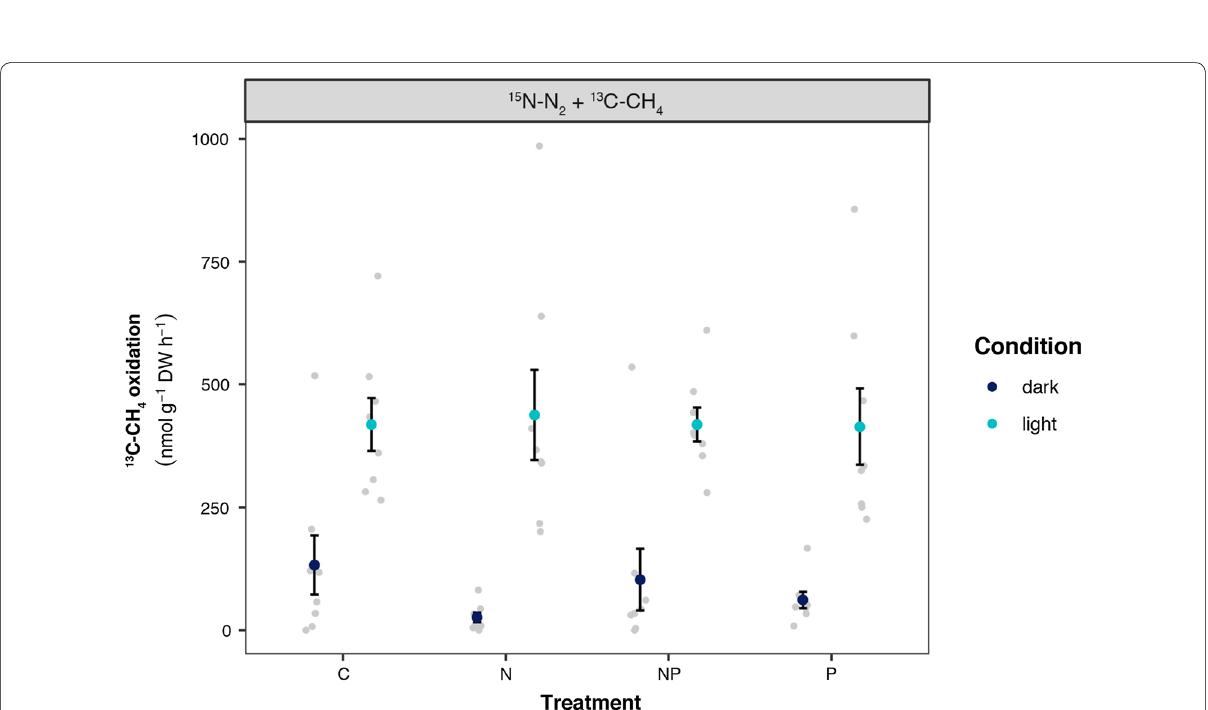
Fig. 4 Plot showing the average CH 4 oxidation rates measured as 13 C–CH 4 incorporation at the end of the experiment, displayed per fertilization treatment. Incubations were performed either in the dark (dark blue) or in the light (light blue). Error bars indicate SEM and light grey dots show raw